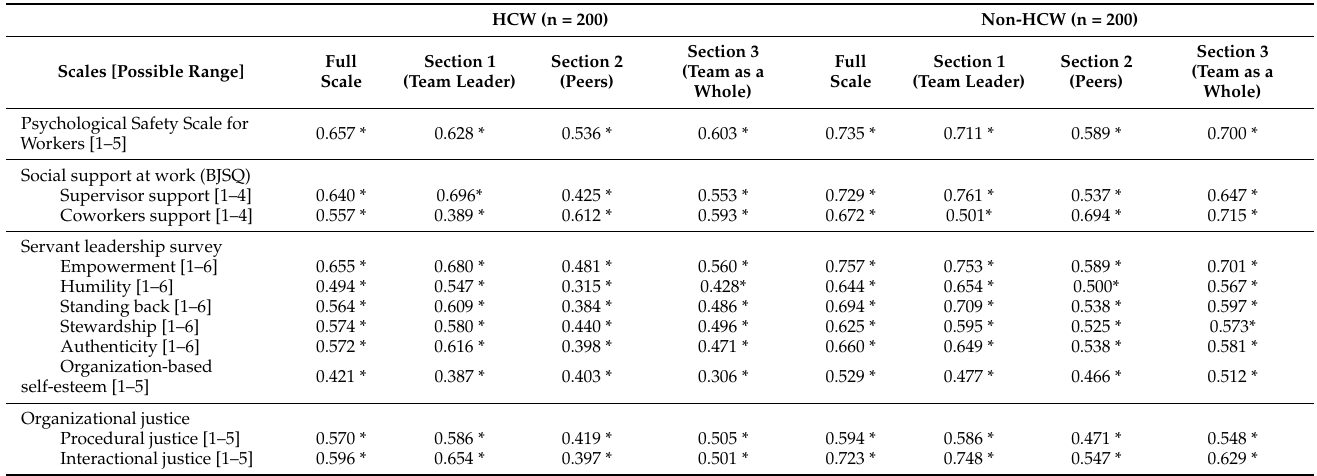
Table 5. Pearson’s correlation coefficients between each subscale on the psychological safety scale and other psychometric scales (convergent